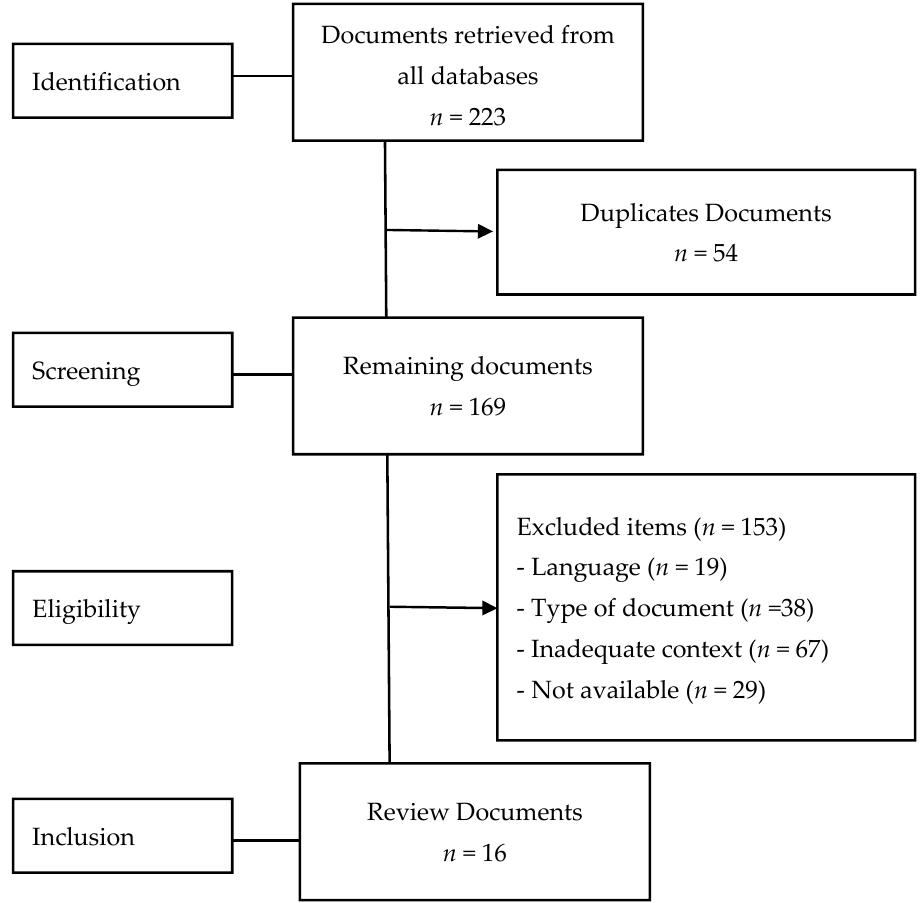
Figure 2. Sample selection flowchart.